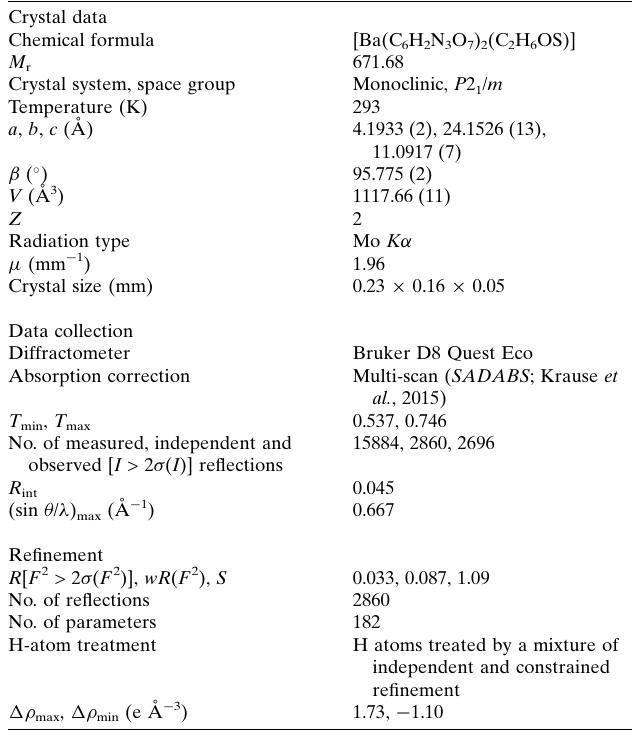
Crystal data Chemical